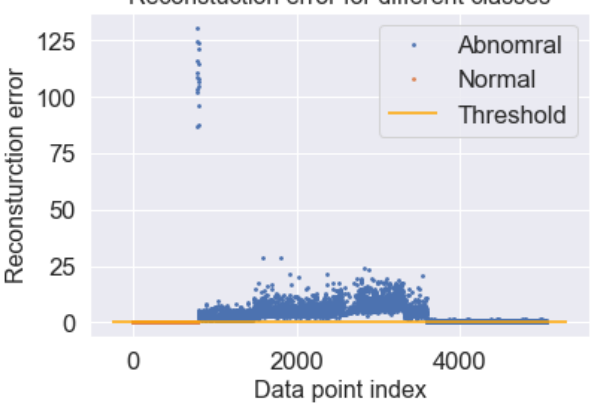
Figure 12. Visualization for the set threshold with reconstruction error for different classes.